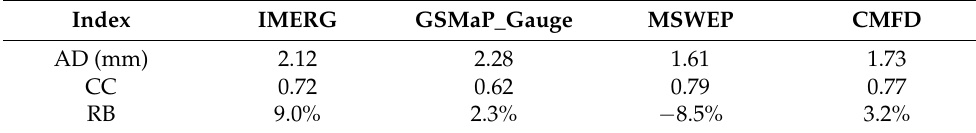
Table 2. The conventional indices of the SPPs in urban area of China.